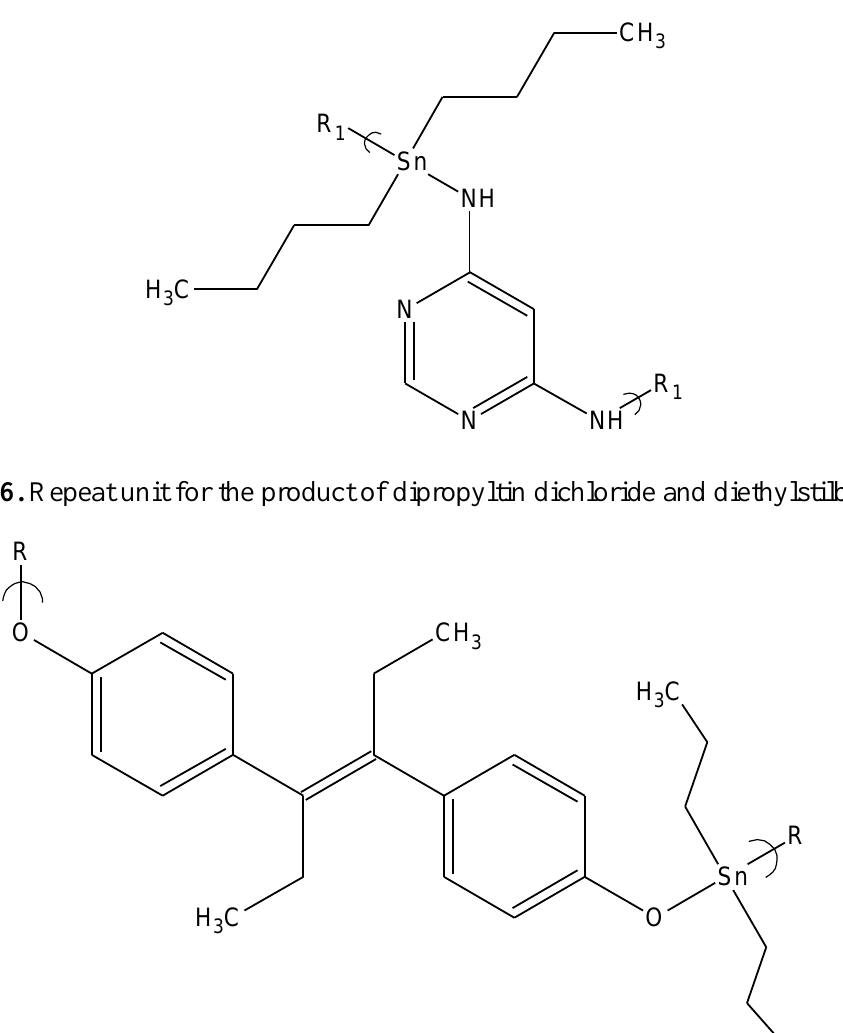
Figure 5. Repeat unit for the product of dibutyltin dichloride and 4,6-diaminopyrimidine.